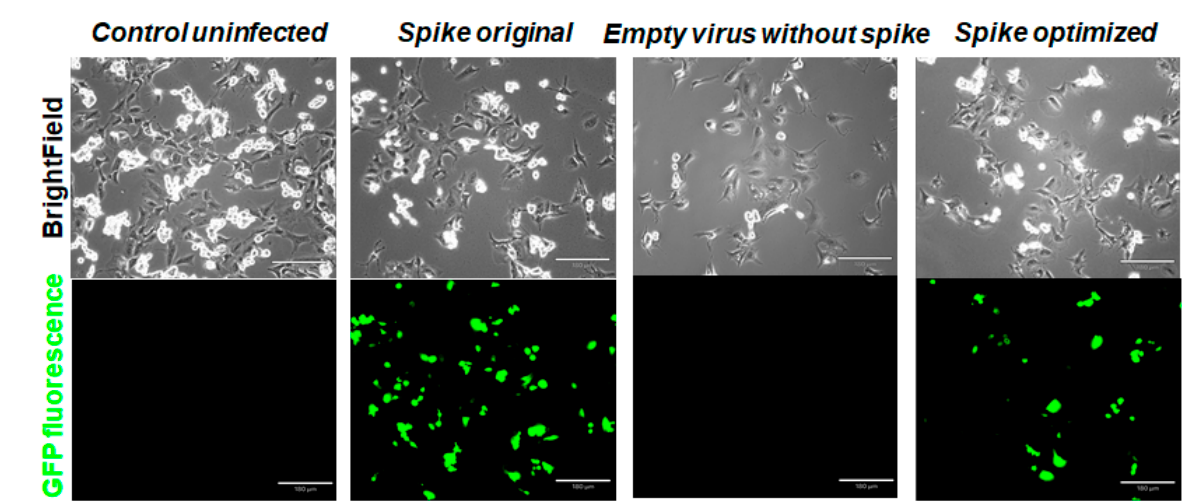
Figure 8. Vero E6 infection with HEK293T-produced pseudovirions measured by GFP fluorescence. Experiments were conducted in duplicate and repeated several times. Scale bar = 180 μ m.